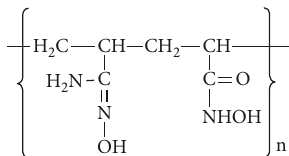
Scheme 1: Structure of poly(amidoxime-hydroxamic) acid sorbent.